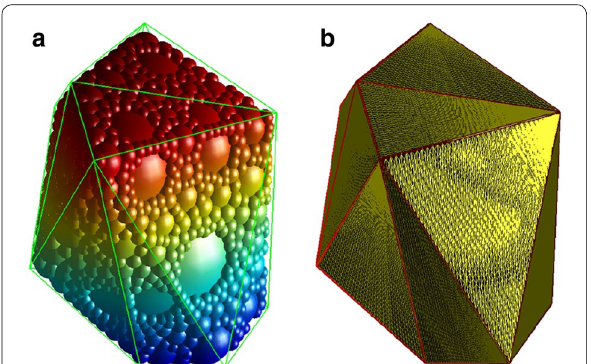
Fig. 1 Cluster generated by MATLAB. a Cluster consists of 1348 paticles, b isoparametric grid map.